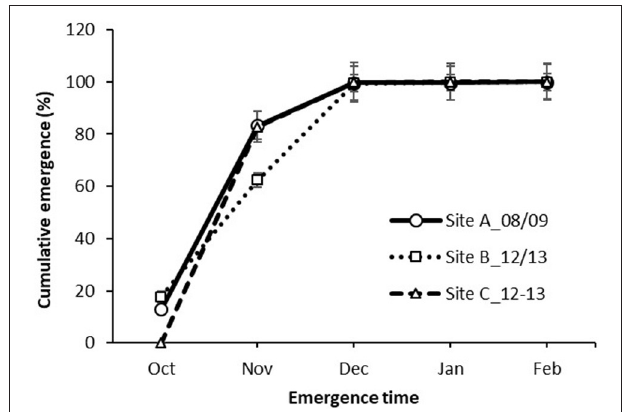
FIGURE 6 | Emergence of P. capillare over time in the field. Emerged seedlings were counted and removed by spraying glyphosate. Vertical bars represent the standard error of the mean. Cumulative emergence (%) was calculated from the cumulative number of emerged seedlings at the respective month divided by the total number of emerged seedlings during the entire experimental